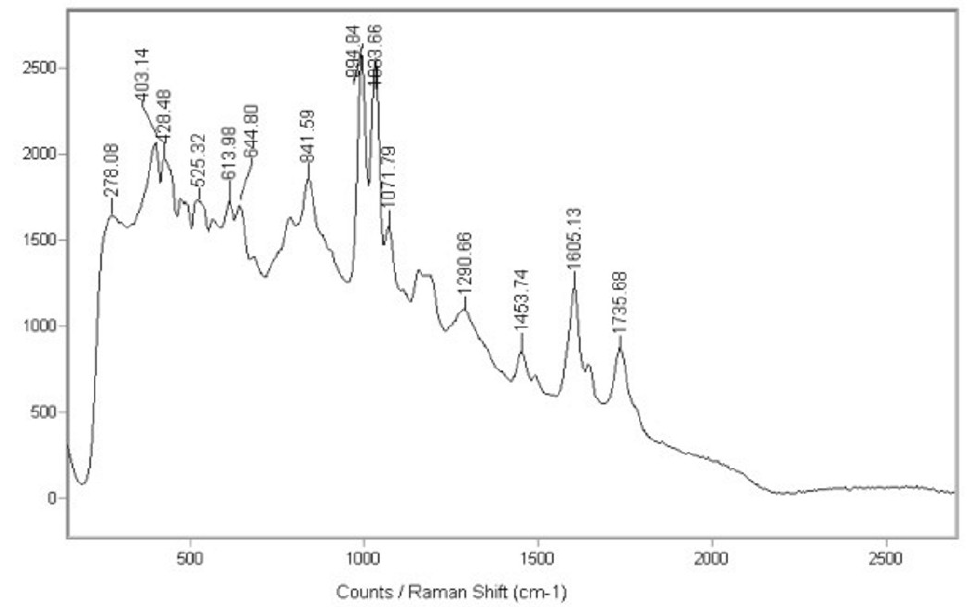
Figure 13. Characteristic Raman spectrum of polyester (AKEMI Marmokitt 1000) - substrate of sculpture “Journey” of Alina